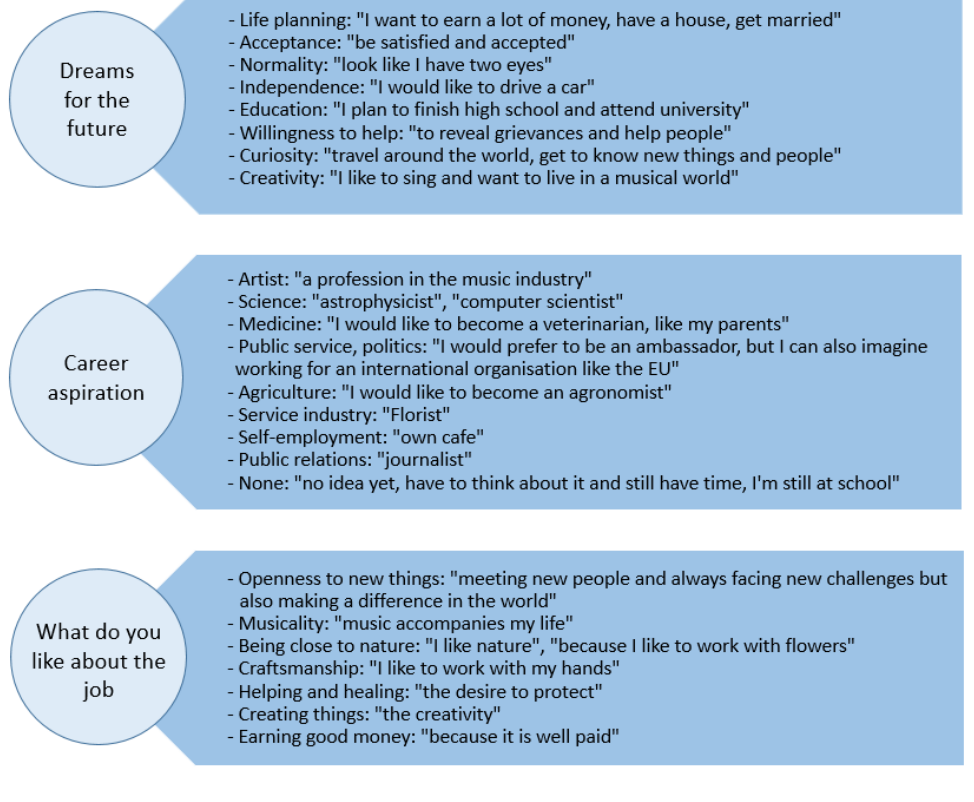
Figure 4. Summary of the open question section. Answers were divided into categories and supported by quotations (in quotation marks).